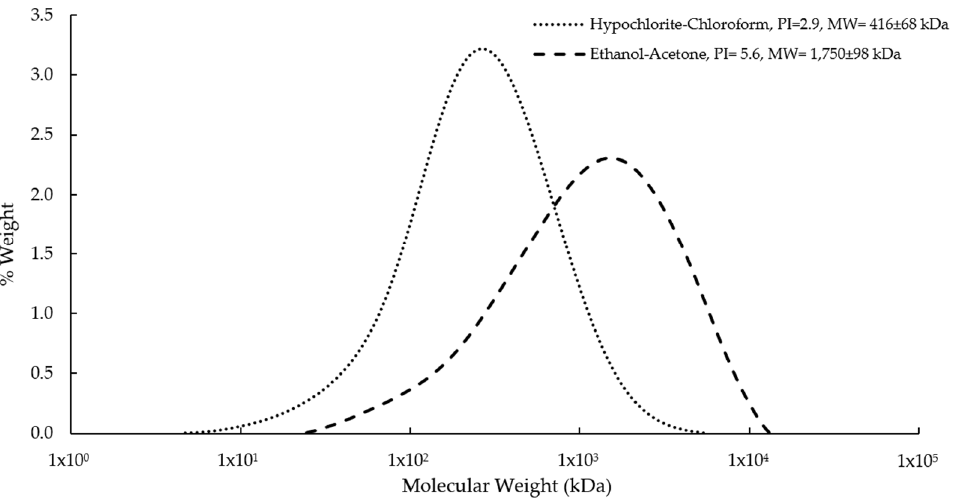
Figure 2. Molecular weight distributions of P3HB isolated from A. vinelandii O PNA cultures using ethanol-acetone and the conventional hypochlorite–chloroform method (Control). ethanol-acetone and the conventional hypochlorite–chloroform method